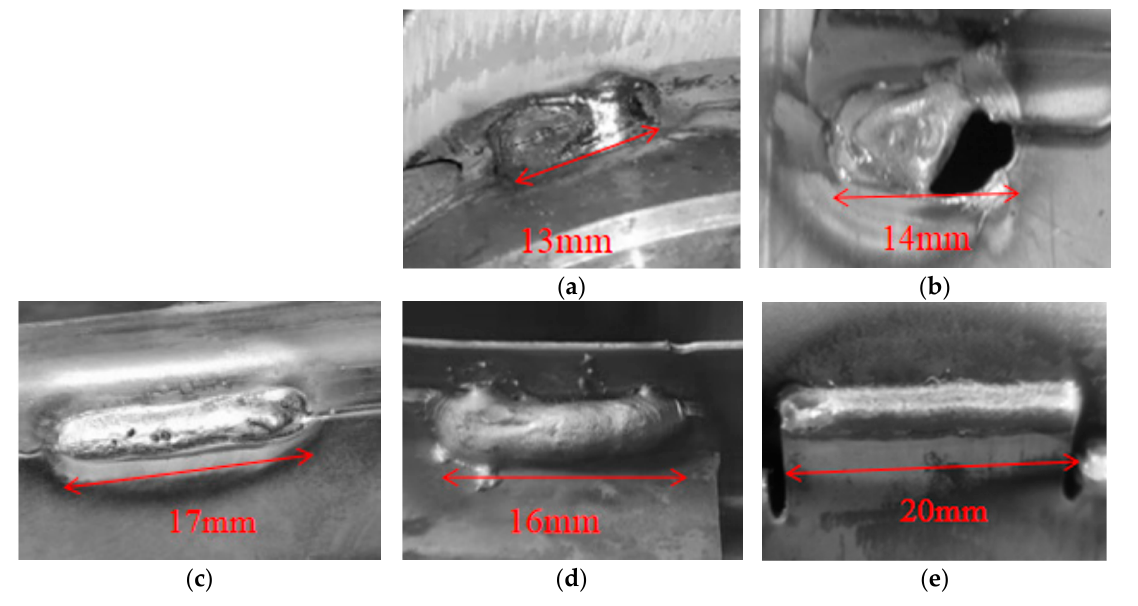
Figure 4. Grayscale images of five welding defects. ( a ) Crack. ( b ) Burn-through. ( c ) Porosity. ( d ) Not fused. ( e ) Normal.